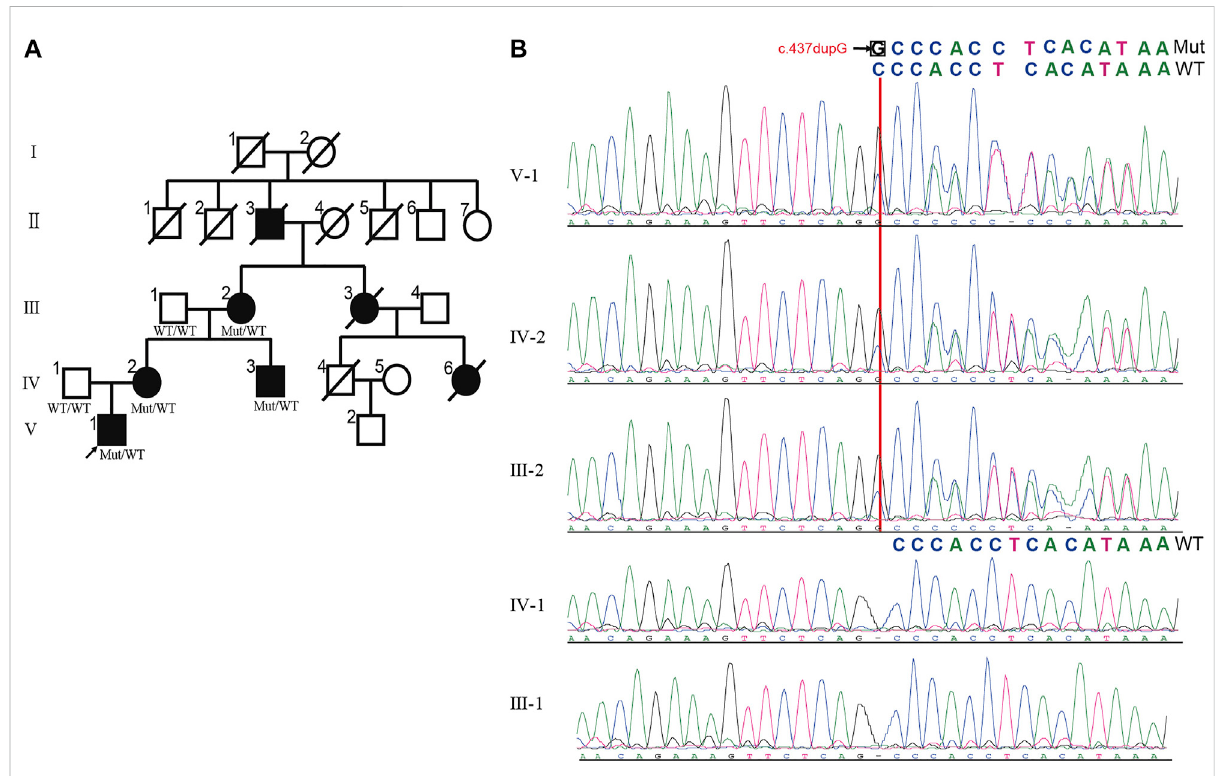
FIGURE 1 The pedigree of HSP with UBAP1 mutation. (A) The inheritance pattern in this family showed classic autosomal dominant inheritance. HSP patients are marked by black symbols. An arrow indicates the proband. The genotypes of all available family members are displayed with c.279delG mutation and wild typeallele. (B) Alignment of Sanger sequencing results showed c.437dupG induced mRNA frameshift of UBAP1 gene. The c.437dupG (red arrow) was detected in patients, but not in healthy members, which showed the mutation is the co-segregation with the manifestations in the family. Notes:Mut, Mutation; WT, wild